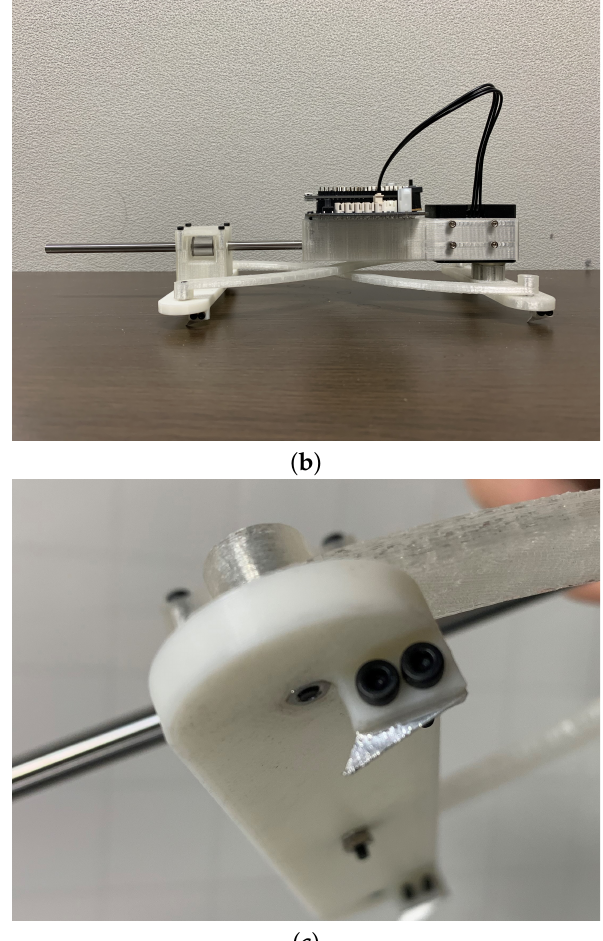
Figure 15. Photographs of the fabricated robot: ( a ) top view; ( b ) side view; ( c ) the claw-shaped leg mechanism.